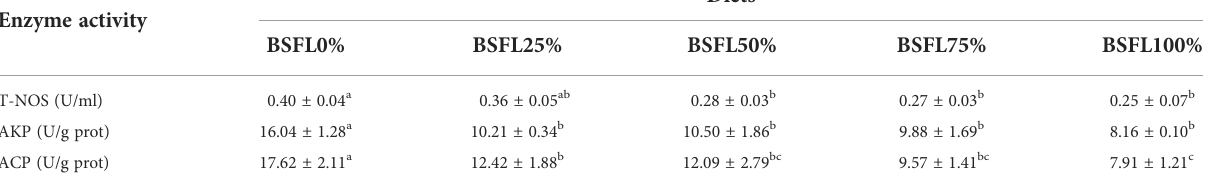
TABLE 4 The hepatopancreatic immune enzyme activities of L. vannamei fed different experimental diets for 8 weeks.